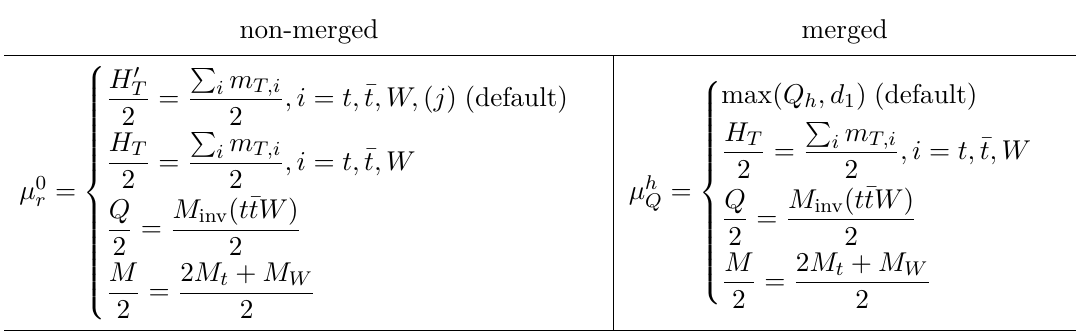
Table 1 . Different functional forms for the central value of the renormalisation scale used for the scale dependence